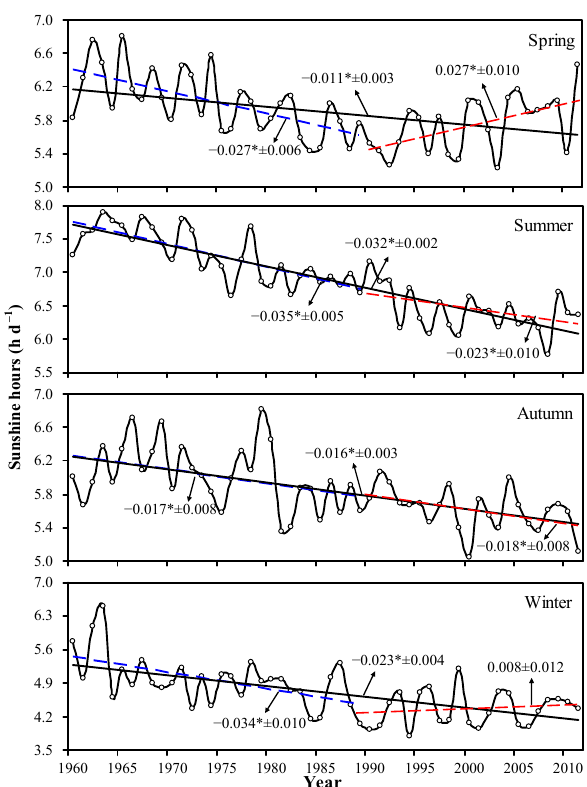
Fig. 4. Time series of seasonally averaged daily sunshine hours of 42 cites across China for the period 1960–2011. Black solid line, blue and red dash lines respectively denote linear trend for the periods 1960–2011, 1960–1989 (dimming phase) and 1990–2011 (brightening phase). Values denote trend slopes and corresponding standard errors, and * is significant trend at the 95% confidence level.